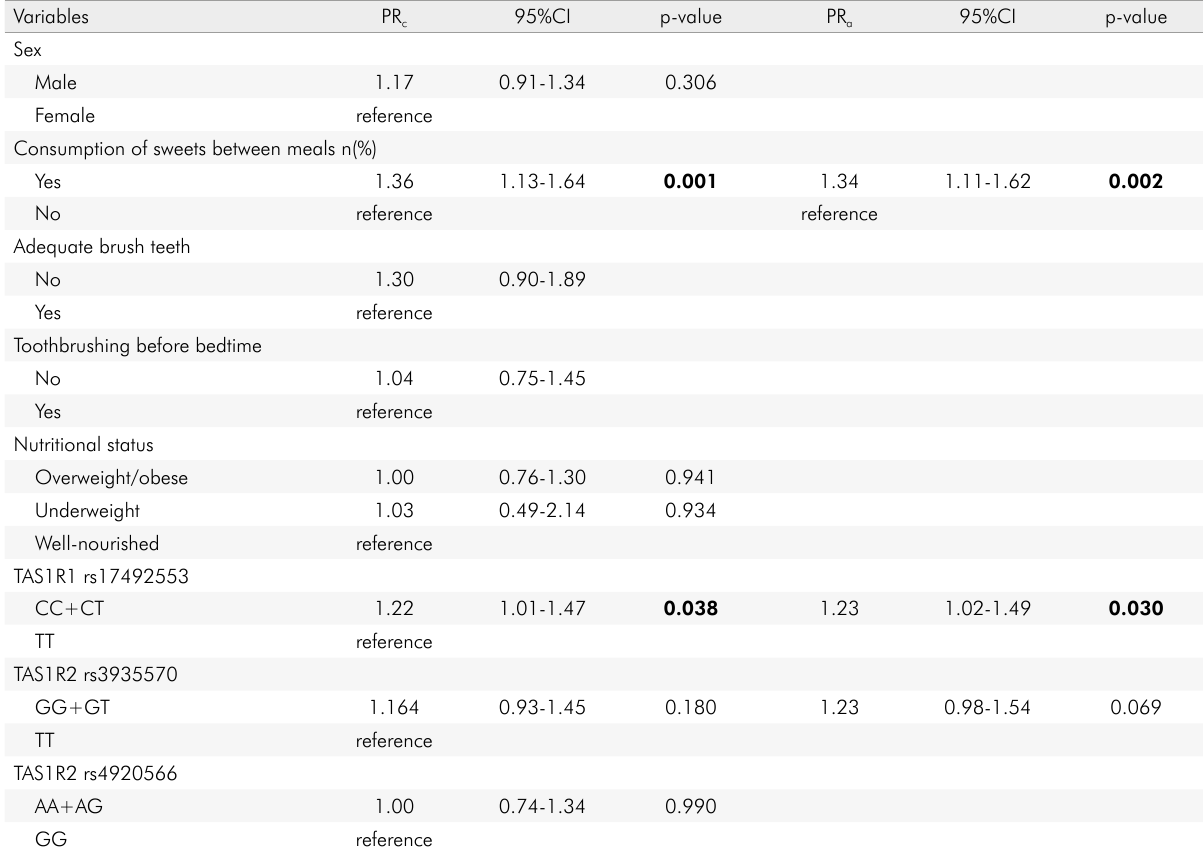
Table 4. Crude prevalence ratio (PR considering environmental and genetic